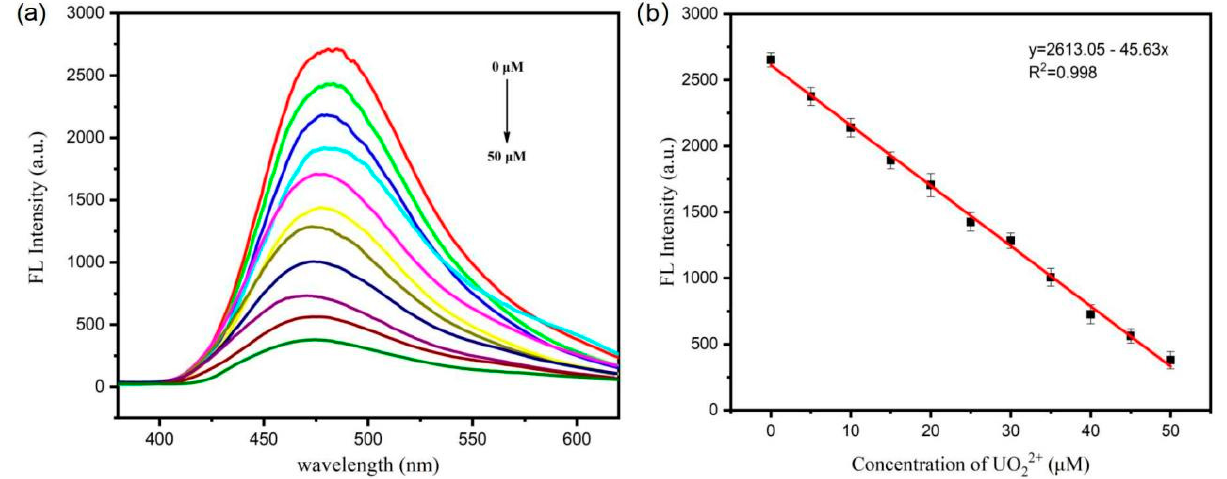
Figure 7. ( a ) Fluorescence intensity change when adding 0–50 μ M of UO 22+ to HTPAF solution ( b ) Correlation between HTPAF fluorescence intensity and UO 22+ concentration (0–50 μ M).